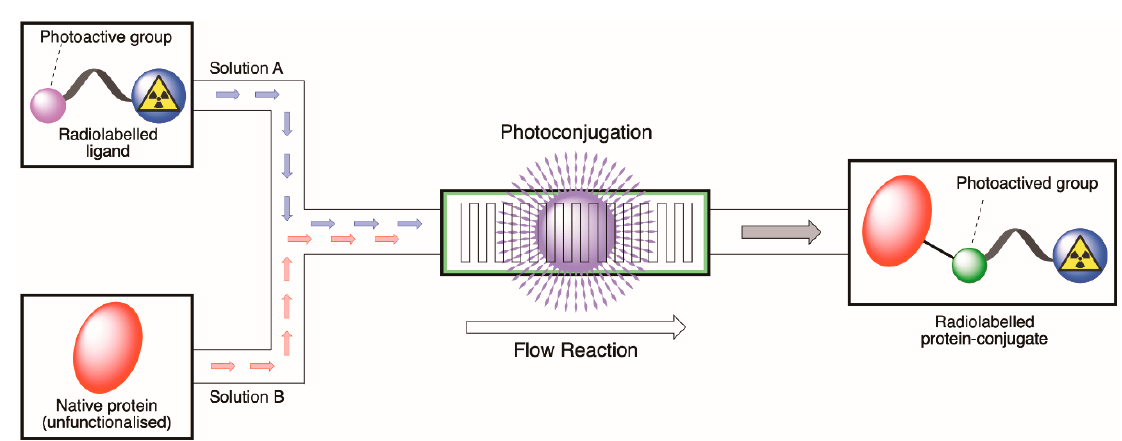
Figure 1. Illustration depicting the general concept of the light-activated preparation of 89 Zr-radiolabelled protein conjugates in a microfluidic photochemistry device.